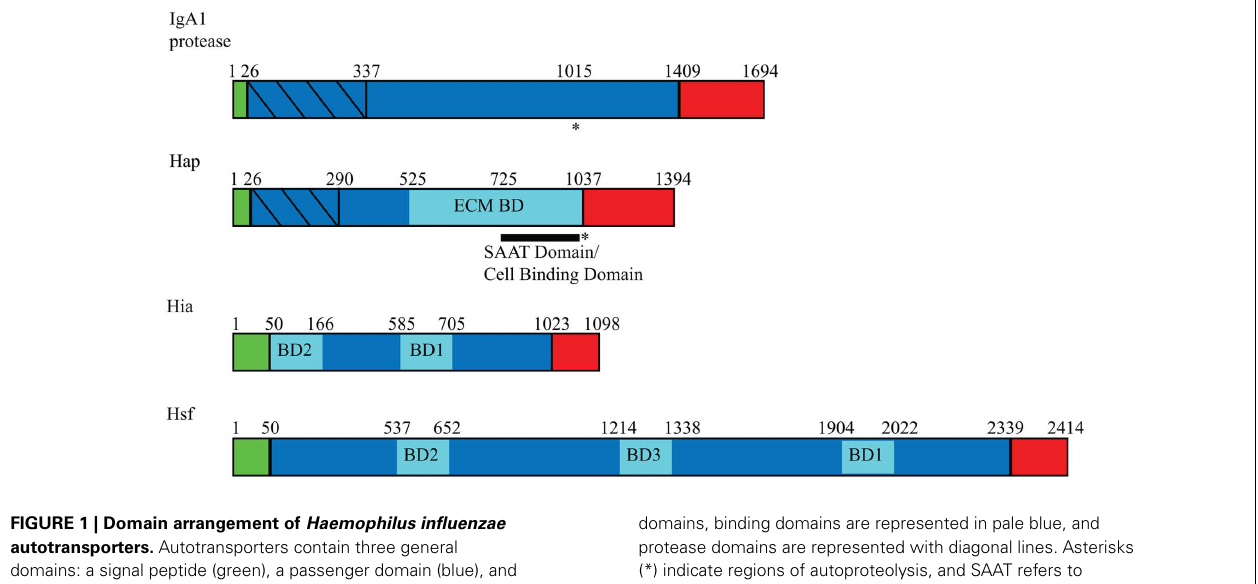
FIGURE 1 | Domain arrangement of Haemophilus influenzae autotransporters. Autotransporters contain three general domains: a signal peptide (green), a passenger domain (blue), and an outer membrane β -barrel domain (red).Within the passenger